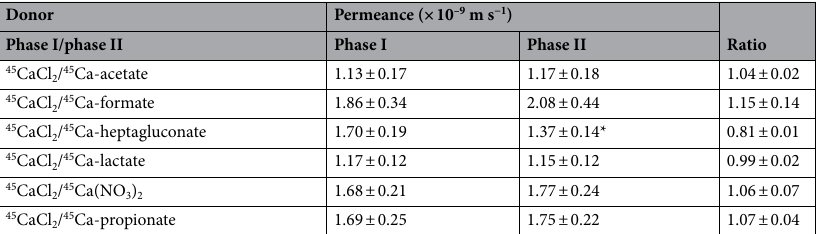
Table 2. Permeance estimates of different Ca-salts through excised skin segments of mature sweet cherry fruit. During phase I of the experiment, 45 CaCl 2 was used as the donor solution. In phase II, the donor solution was replaced by 45 Ca(NO 3 ) 2 or by one of the organic salts 45 Ca-acetate, 45 Ca-formate, 45 Ca-heptagluconate, 45 Ca-lactate or 45 Ca-propionate. The change in permeance between phases I and II is specified as the ratio phase II/phase I (for an example of the time course see Fig. 2). *Significantly different from the permeance in phase I. The other phase I: phase II pairs are not significantly different. Paired Student’s t test at p ≤ 0.05.